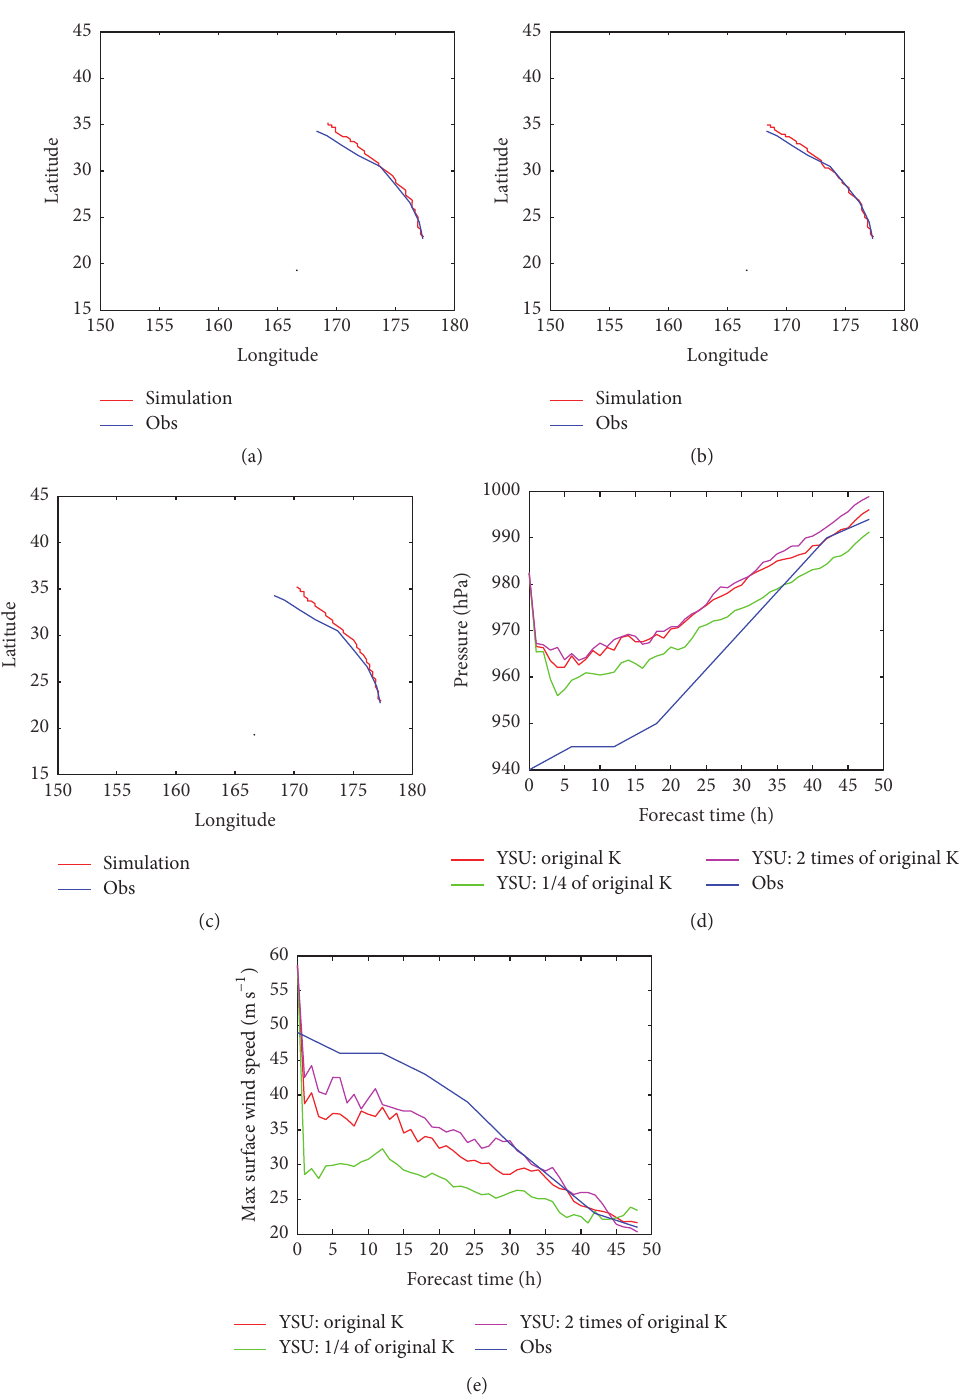
Figure 4: Case 3-Genevieve: (a) track simulated by the original YSU; (b) track simulated by the K025; (c) track simulated by the K200; (d) comparisons of center sea-level pressure; and (e) comparisons of maximum surface wind